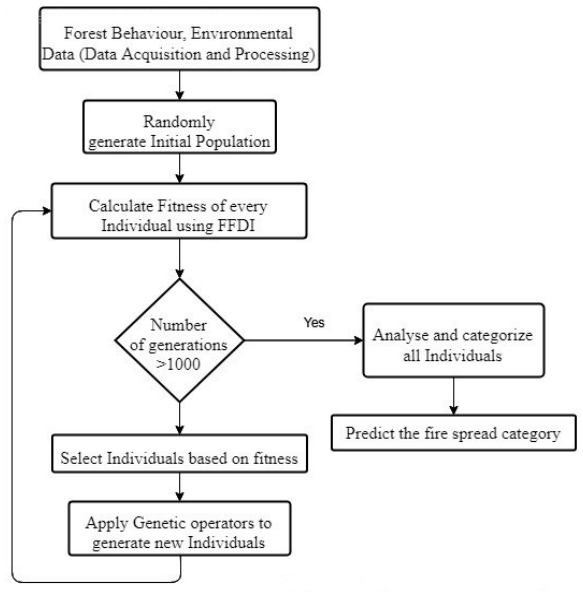
Fig. 1. Working of Genetic Algorithm